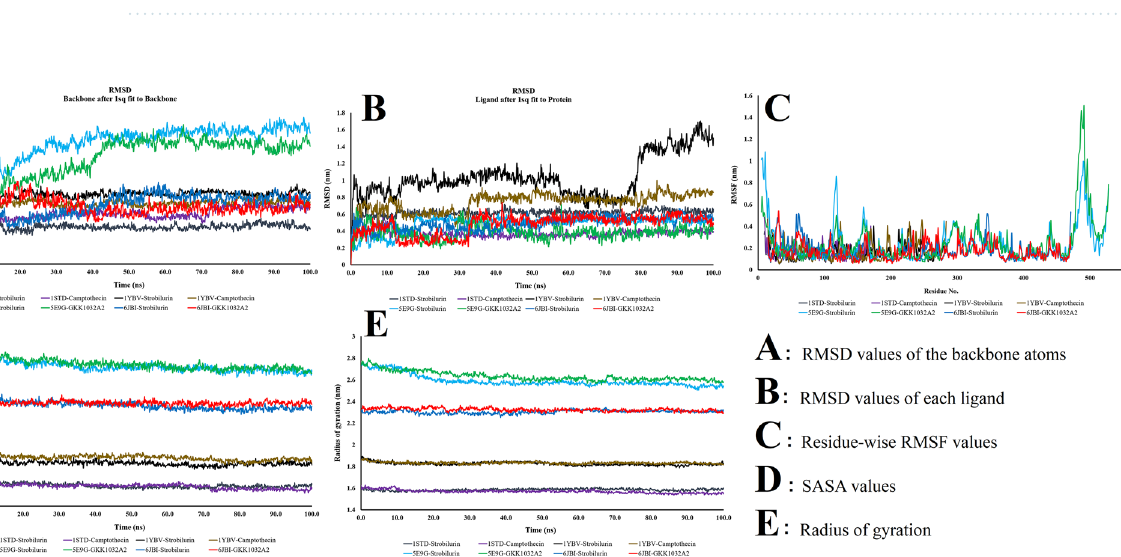
Table 4. Prediction of bioactivity of the selected compounds and reference fungicide compounds.